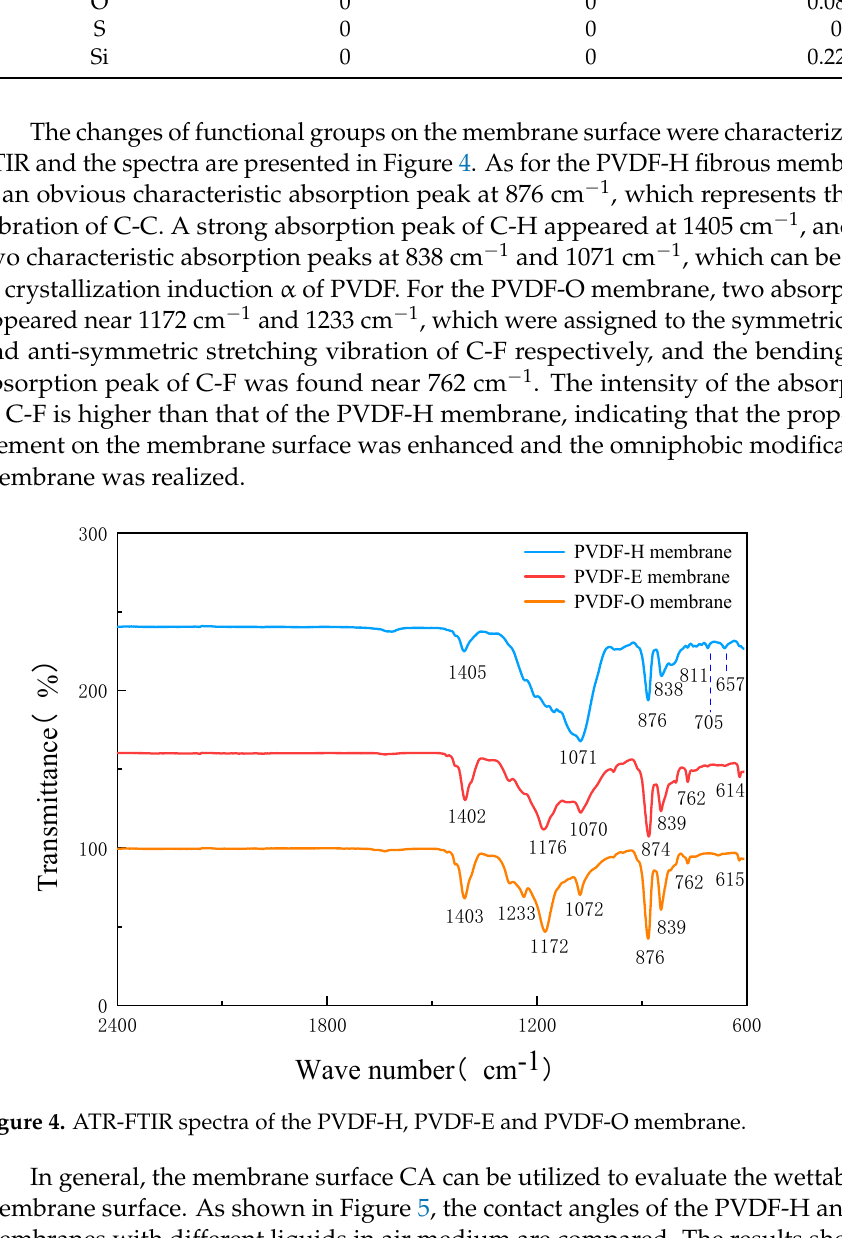
Figure 5. Contact angles of different liquids on the surface of PVDF-H and PVDF-O membrane. In the process of preparing omniphobic membranes by electrospinning, the addition of ammonia to the spinning solution plays four key roles [14,15]: (1) As shown in Figure 3f, the addition of inert ammonia solvent makes the membrane fiber rough and also im- proves the roughness of the membrane surface, making the hydrophobic property of the membrane better; (2) The addition of ammonia encourages local microphase separation,